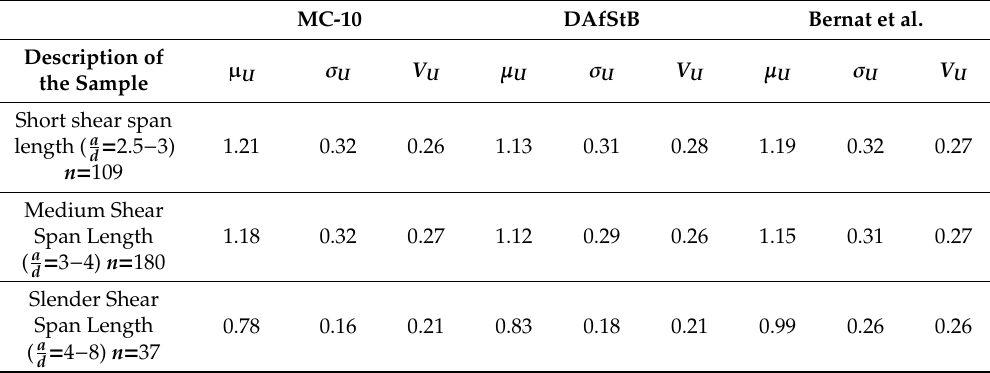
Table 5. Model uncertainty statistics for di ff erent subsets of